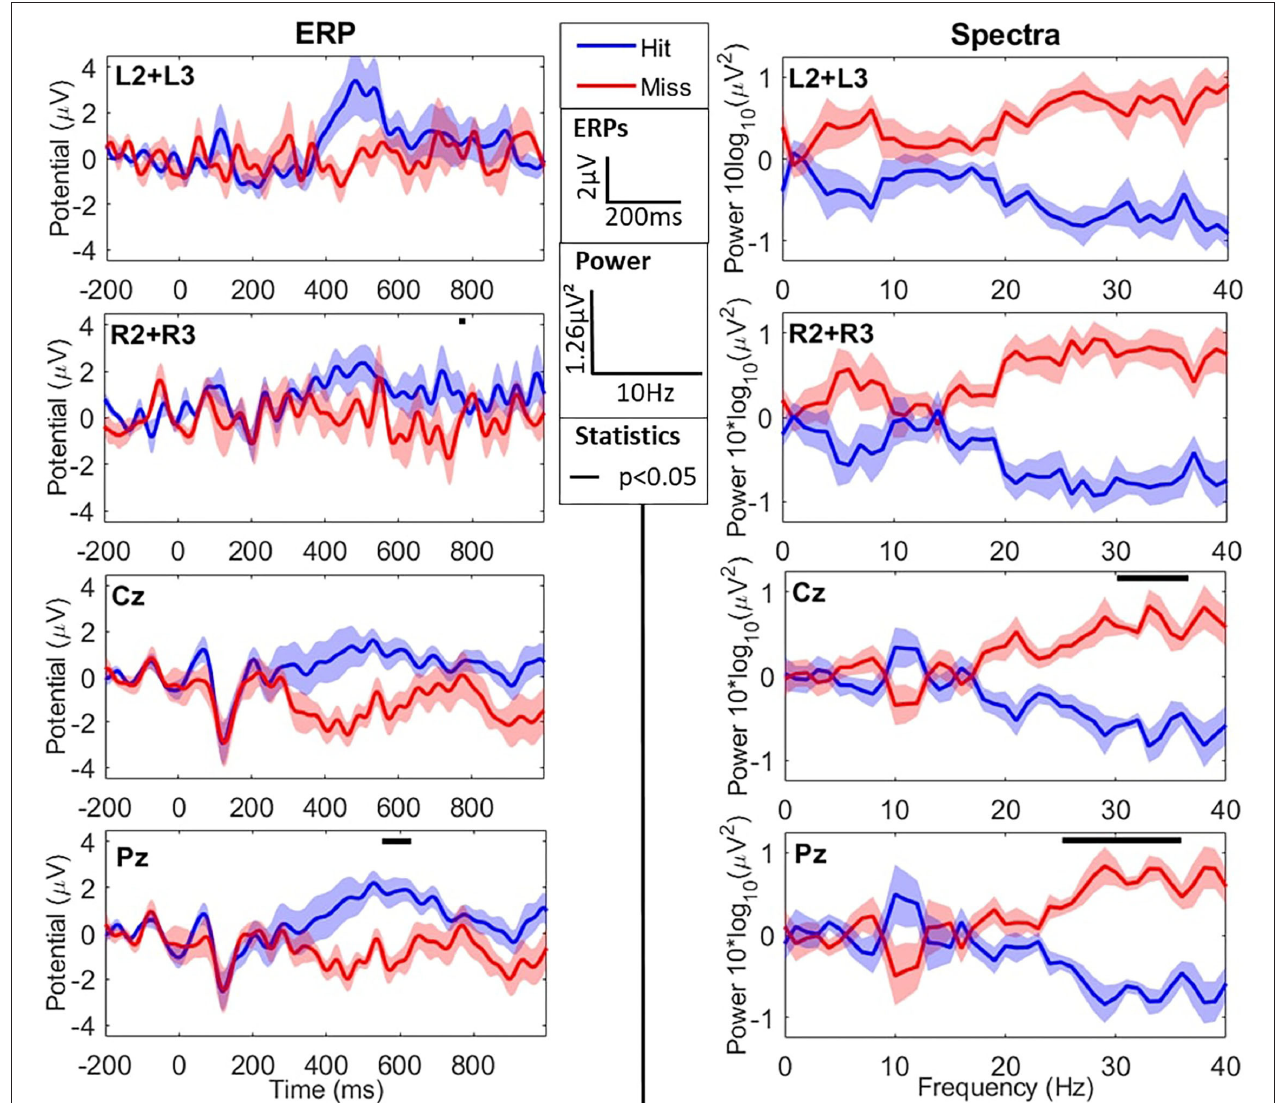
FIGURE 3 | EEG results in the time (ERPs–left column) and frequency (Spectra–right column) domains for the oddball task during flight simulation. The two first lines show cEEGrid data, whereas the two last ones show Enobio data. Data are averaged across difficulty levels (refer to sections 3.2.1.1 and 3.2.2.1) and show grand averages across participants for hits (blue) and misses (red). ERPs are averaged for each type of trial from − 200 ms to 1 s around sound presentation ( t = 0). Power Spectral Densities (PSD) are presented with individual means subtracted from spectra. From first to last, lines show the averages at the left grid L2+L3 electrodes, the right grid R2+R3 electrodes, Cz electrode, and Pz electrode. Black lines at the top of graphs show windows (in time or frequency) where averages for hits and misses are significantly different. ERPs (in µ V ) and spectra (as 10 × log 10 ( PSD ) in µ V 2 ) are presented as mean ± SD across